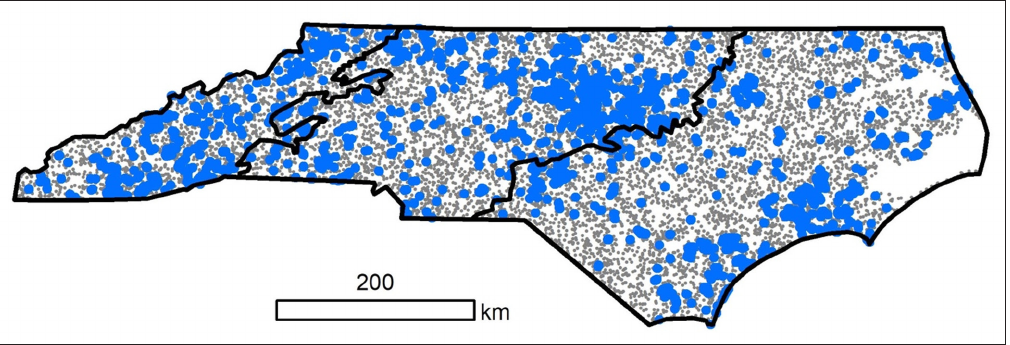
Figure 1 Map of the 9,586 random points ( grey ) across North Carolina, USA used to quantify variation in available habitat types, and the 4,295 sites sampled with camera traps ( blue ). Black lines indicate the three primary ecoregions (from west to east): mountains, piedmont,